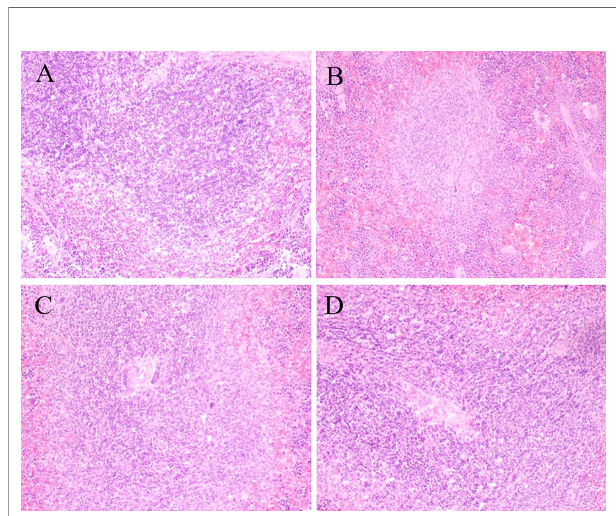
FIGURE 4 | Effects of SPSP on the histopathological changes of the spleen. After SPSP treatment for 14 days, histopathological changes of the spleen were analyzed by image Pro-Plus 7200 software. The samples were HE stained and observed under 200× magni fi cation. (A) Normal control group, (B) BDS model group, (C) L-SPSP (0.1 g/kg) group, (D) H-SPSP (0.4 g/kg)